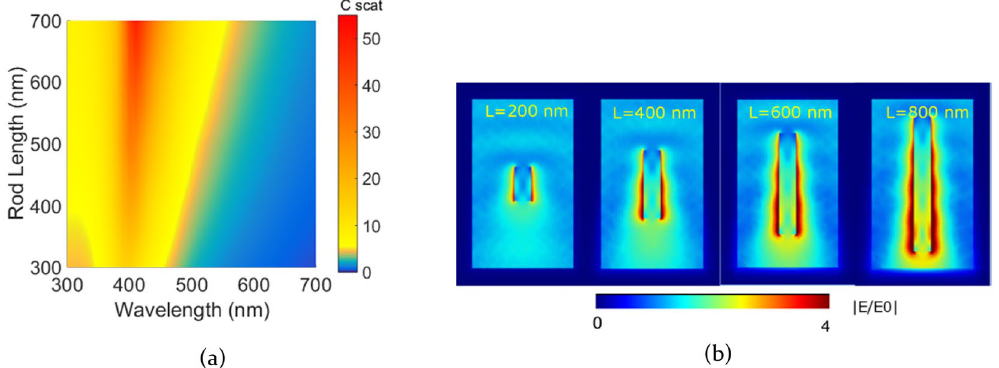
Figure 4. ( a ) Scattering cross section spectra for different ZnO rod lengths having radius 60 nm in air ( b ) near field observed at light wavelength of 500 nm for lengths 200, 400, 600 and 800